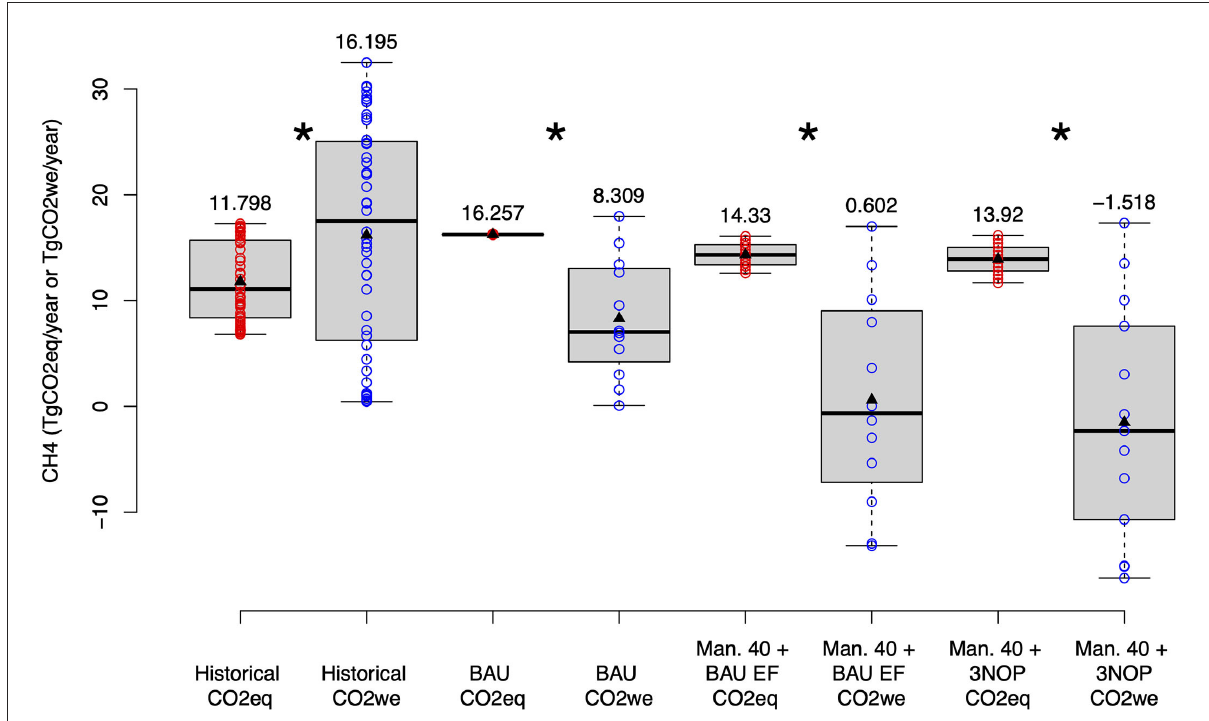
FIGURE1 Comparison of annual total dairy CH 4 emissions converted to CO 2 eq and CO 2 we using GWP and GWP*, respectively. The x -axis shows each emission scenario and which metric was used. Historical data is from 1950 to 2017. The BAU scenario and Manure 40 plus BAU EF (“Man. 40 + BAU EF”) are from 2018 to 2029. The Manure 40 plus 3NOP (“Man. 40 + 3NOP”) is from 2018 to 2030. The y -axis denotes CO 2 -equivalent or CO 2 -warming equivalent emissions, respectively, computed from CH 4 emissions; GWP gives “CO 2 eq” emissions, while GWP* gives “CO 2 we.” Each circle represents an observation of annual emissions rate from each time period and emissions scenario. Red open circles are data points calculated using GWP; blue open circles are data points calculated using GWP*. Values above boxes are mean values; means are denoted as black triangles on plot. Asterisks between plots indicate means of GWP- and GWP*-based emissions differ significantly (paired student’s t -test, p <